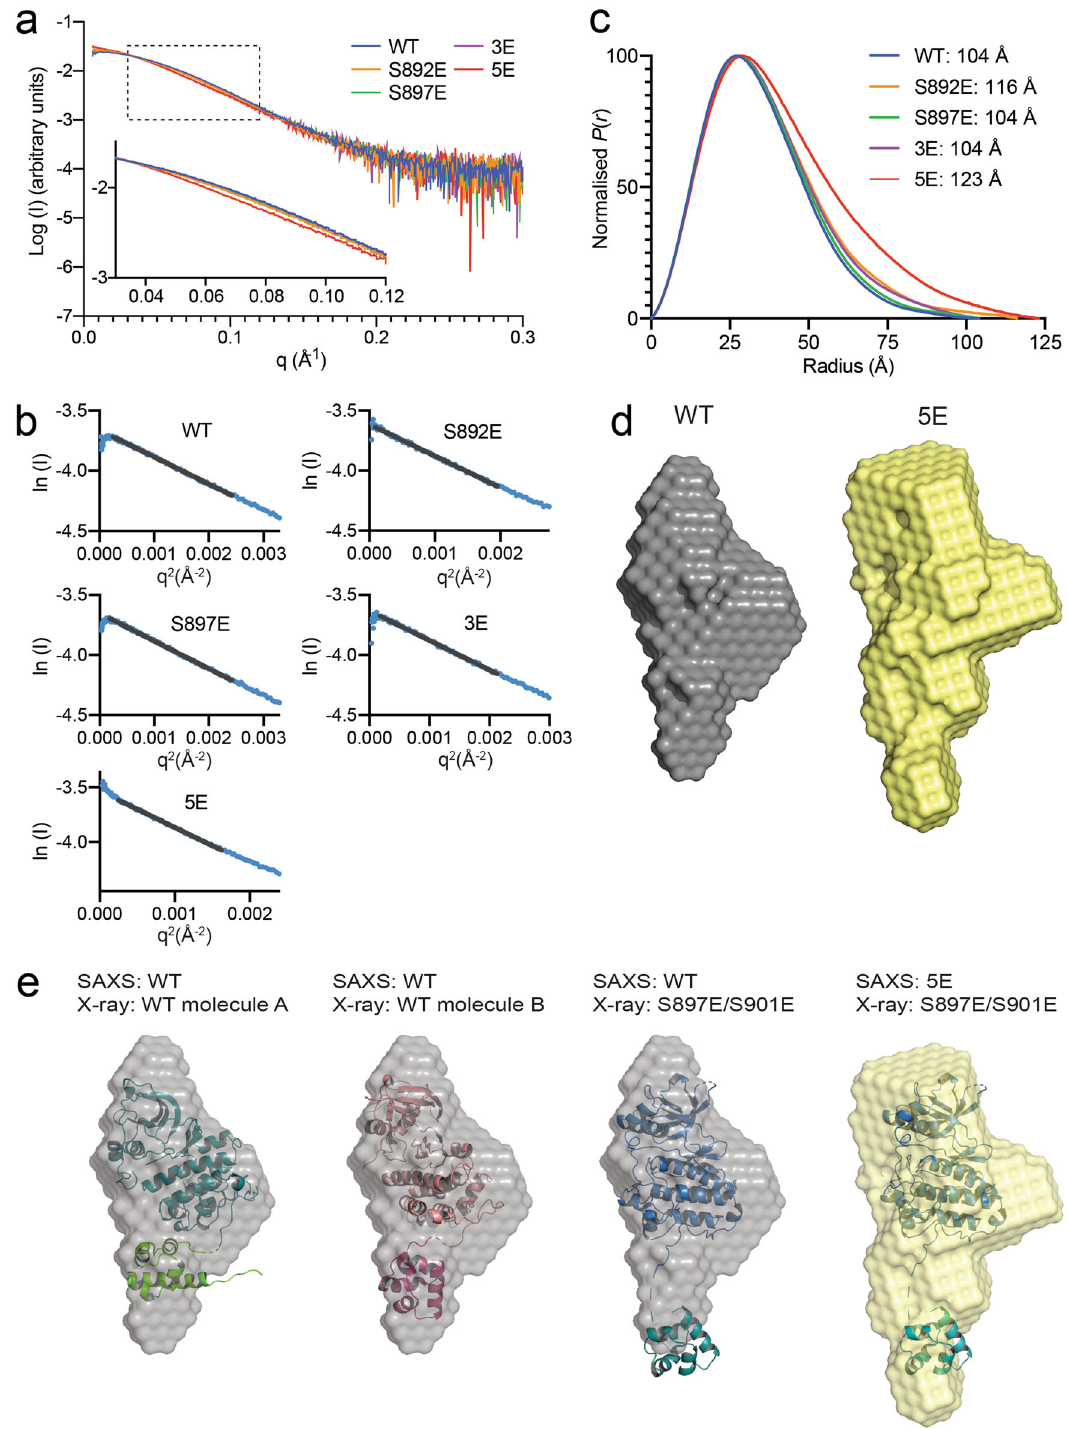
Fig. 3 SEC-SAXS analysis of the EphA2 intracellular region. a Small angle X-ray scattering pro fi les of averaged, and background subtracted data from the apex of the inline size exclusion chromatography peak for EphA2 WT (residues S570-I976) and 5 mutants as indicated. b Guinier analysis of the data shown in a ; the Guinier fi t is indicated by a black line. c Pairwise distance distribution, P ( r ), plot, calculated from scattering data with GNOM. Maximum particle dimensions ( D max ) are indicated for each mutant. d Ab initio SAXS envelopes for EphA2 WT and EphA2 5E calculated with DAMIFF. e Comparison between SAXS envelopes for EphA2 WT and 5E mutant with the crystal structures of EphA2 WT (molecules A and B) and the S897E/S901E mutant. Source data for a , b , c are provided in the Source Data fi